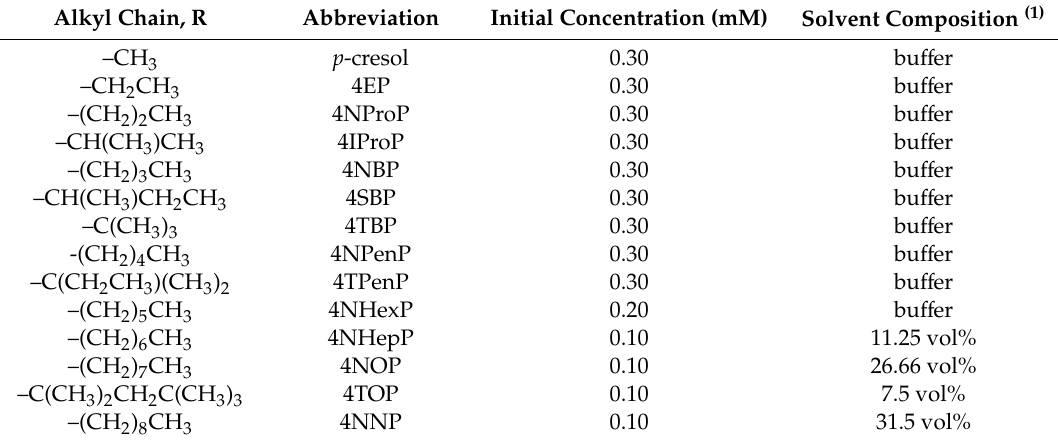
Table 1. Preparation of the solutions of linear and branched alkylphenols used in this